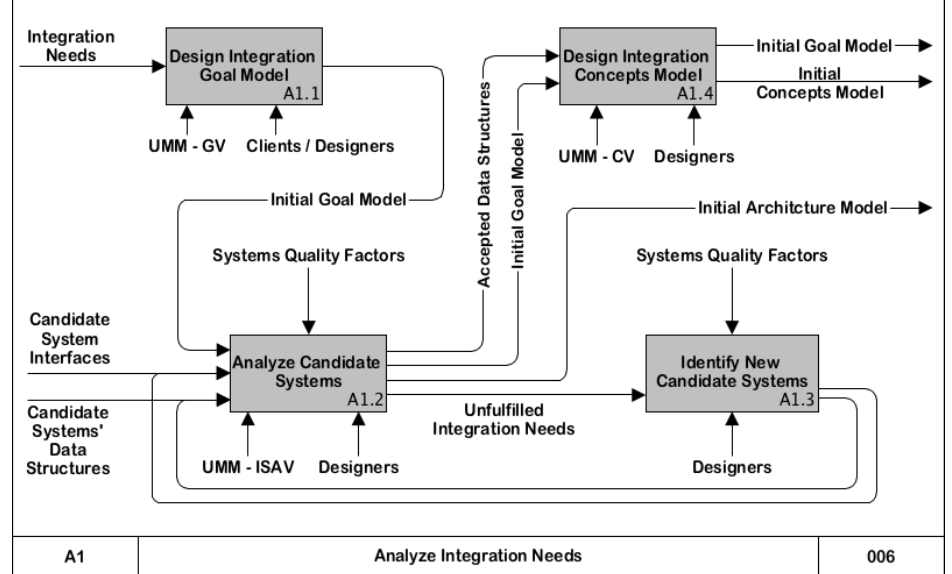
Figure 3. Details of the first stage of the methodology. Level A1 of the IDEF0